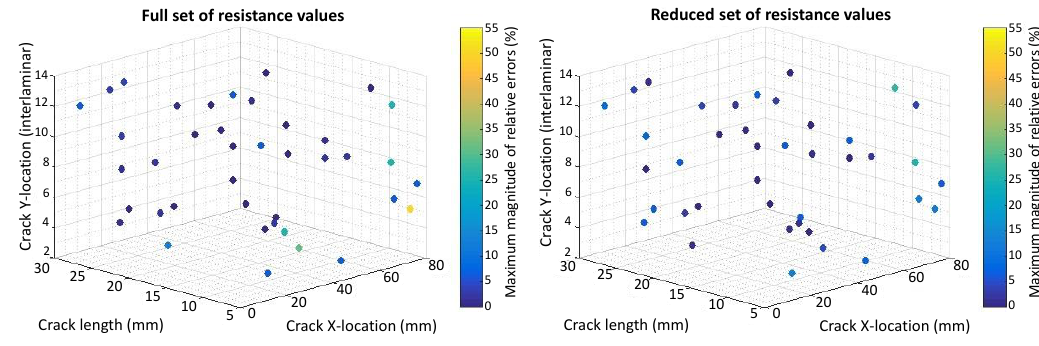
Figure 9. Scatter plot with maximum magnitude of relative errors obtained at the 40 test points used ] for inverse identification in a [( 0/90 ) s laminate using eight electrodes and considering: ( 4 resistance measurement set; ( right ) Reduced resistance measurement set using EI.